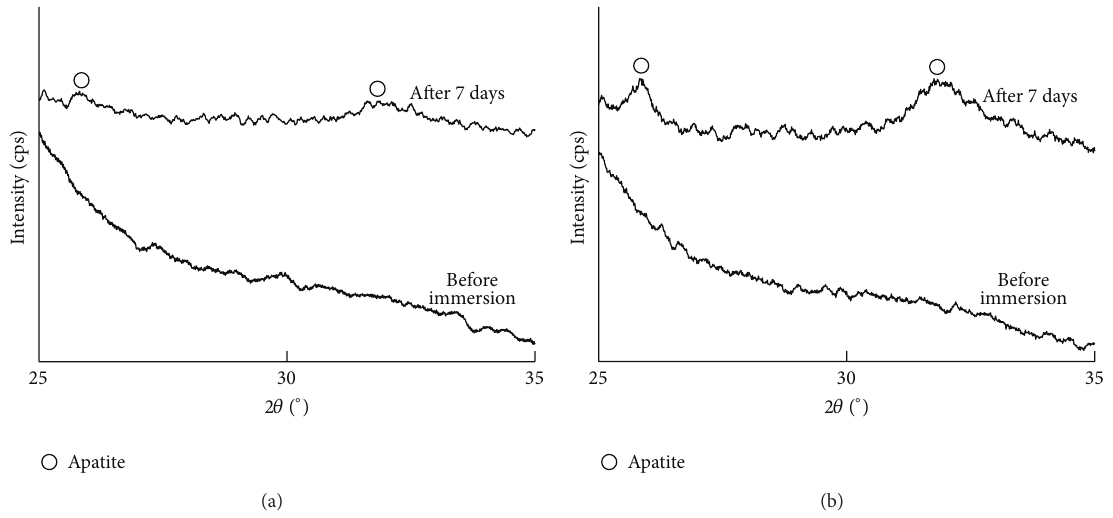
Figure 5: TF-XRD patterns of the PDLLA. Both PDLLA-R and PDLLA-COOH exhibit apatite peaks at 25.86 ∘ and 31.76 ∘ . (a) PDLLA-R; (b)